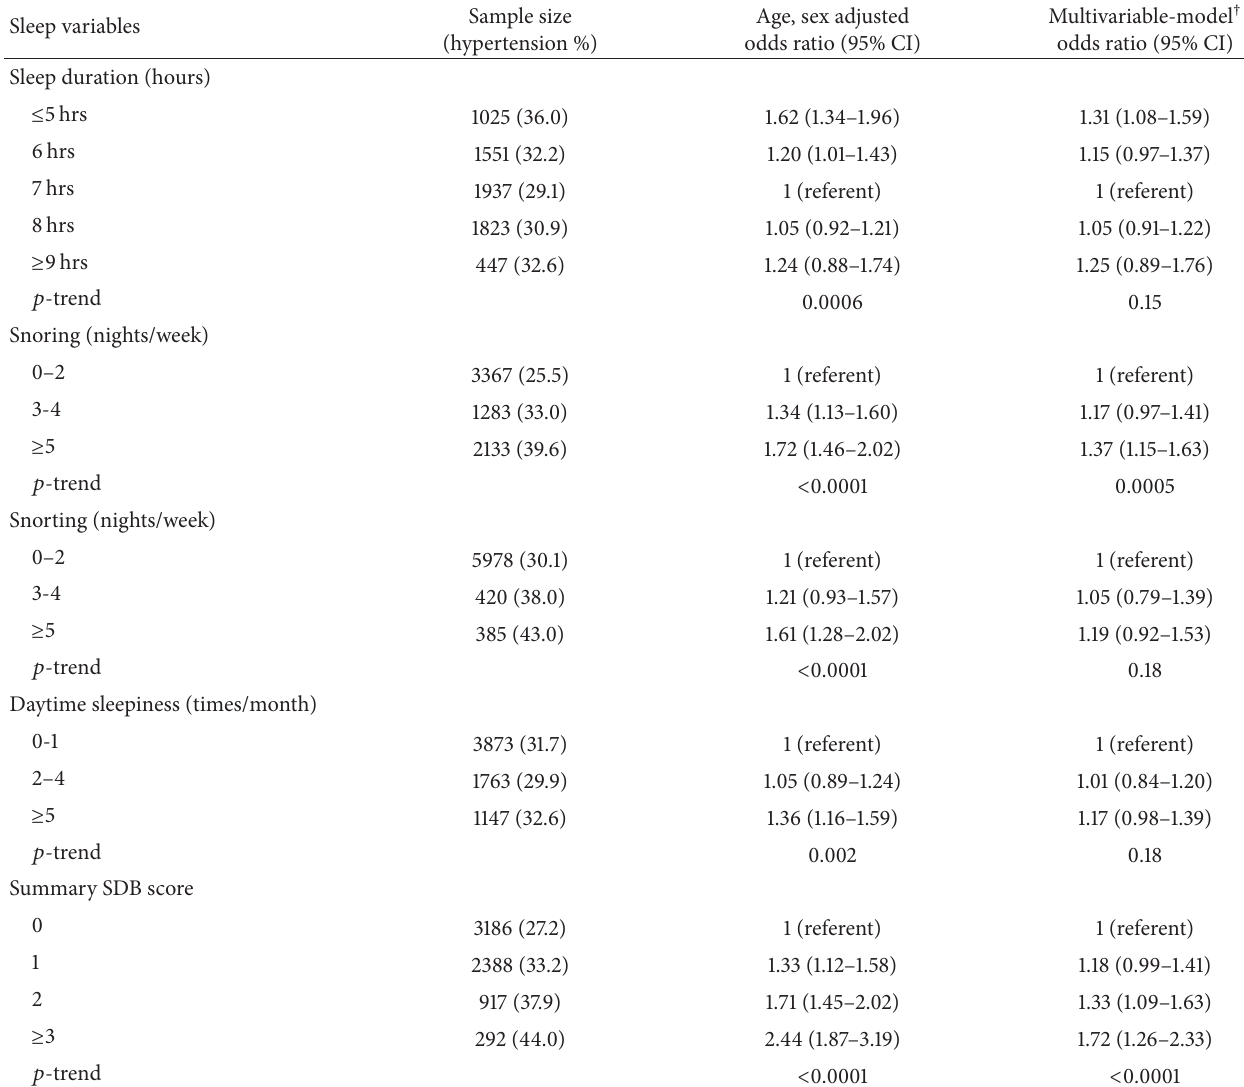
Table 2: Association between sleep variables and